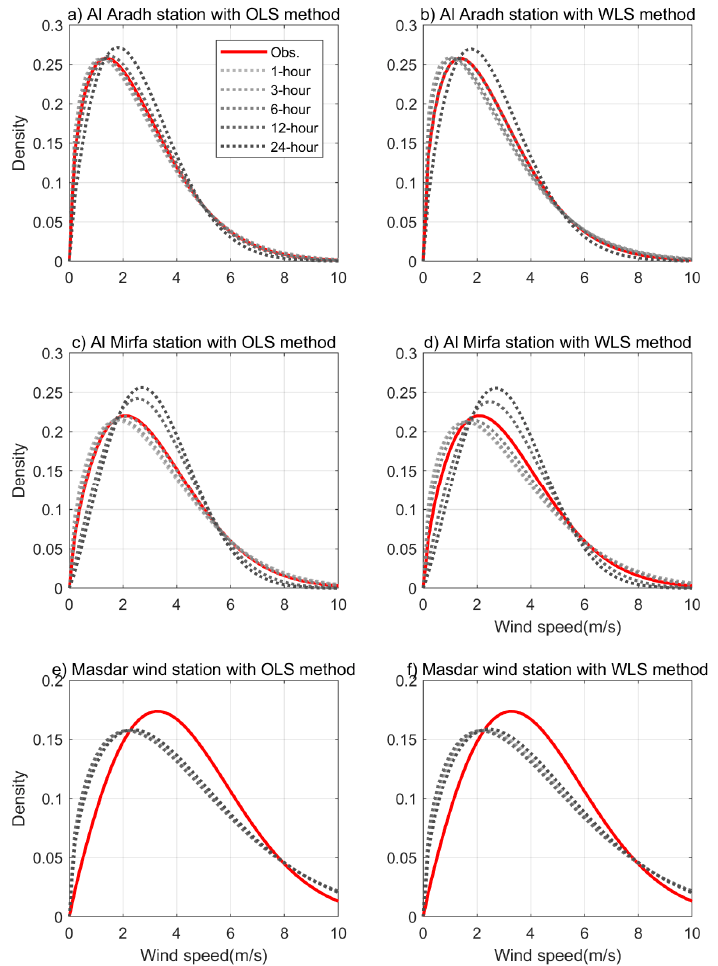
Figure 10. Observed and downscaled Weibull PDFs with the OLS and WLS methods for six stations with Weibull PDF observations. Note that the target temporal resolution of the downscaling method is 10 min. The red line indicates the Weibull PDF that is fitted by the method of moments for 10-min mean wind speed data. The observed distribution (red solid line) indicates the Weibull distribution of 10-min wind speed data fitted using the method of moment. Note that ( a ), ( b ), ( c ), ( d ), ( e ), and ( f ) present the pdfs of Al Aradh with OLS, Al Aradh with WLS, Al Mirfa with OLS, Al Mirfa with WLS, Masdar wind station with OLS, and Masdar wind station with WLS, respectively.